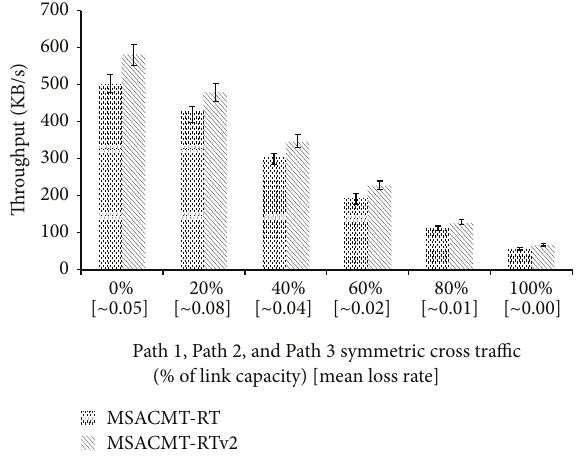
Figure9:MSACMT-RTversusMSACMT-RTv2duringasymmetric loss.